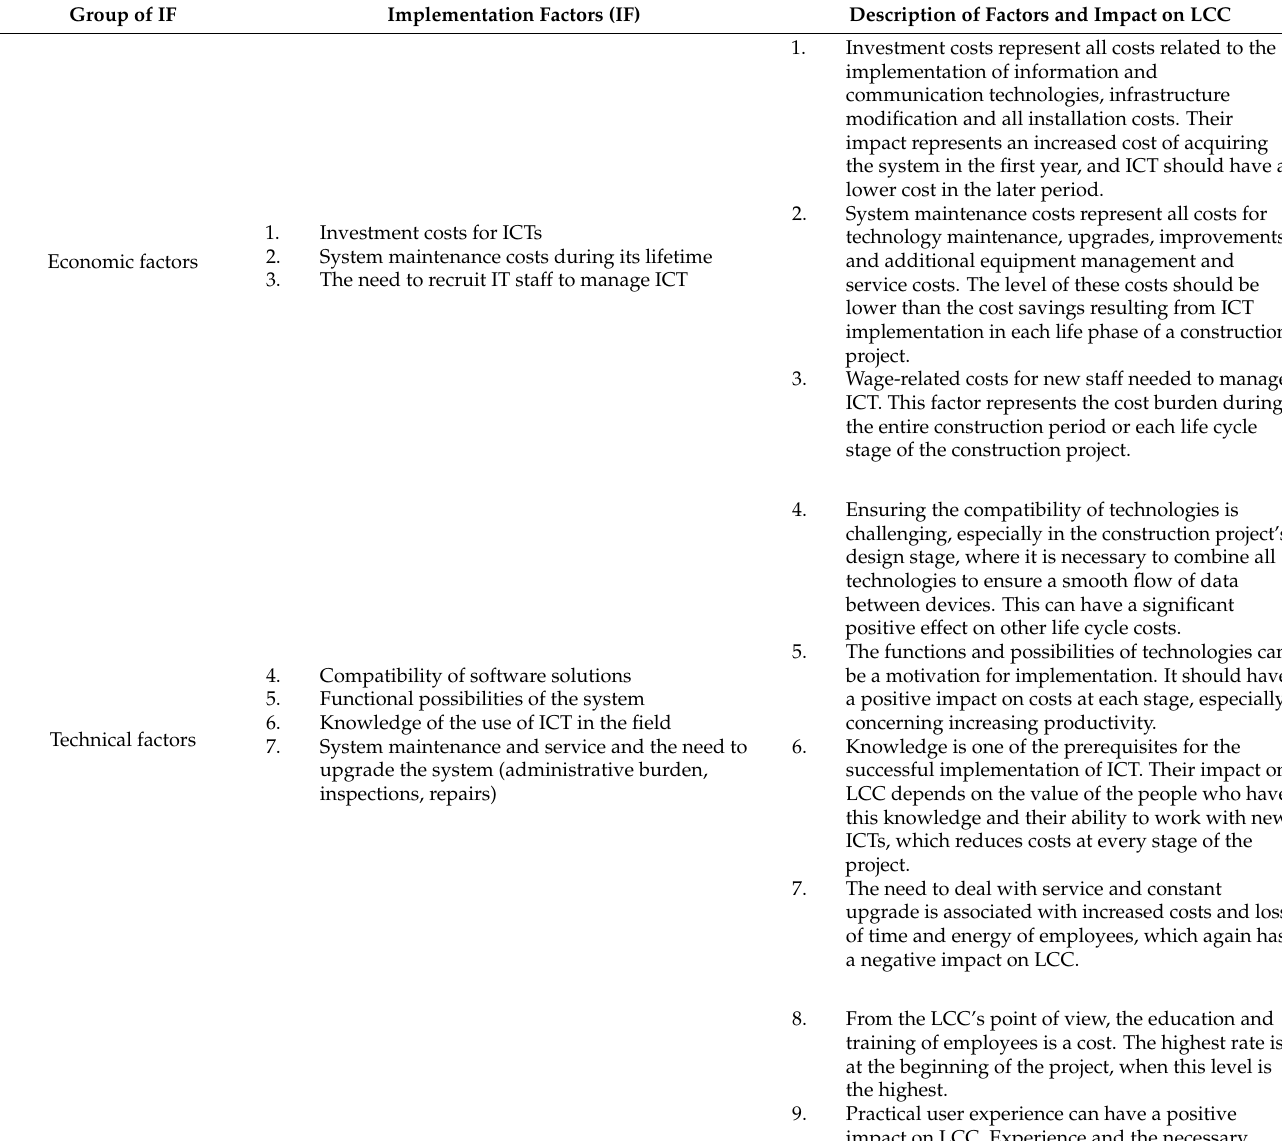
Table 2. Research ICT implementation factors in the construction industry (based on literature review and expert statements). Group of